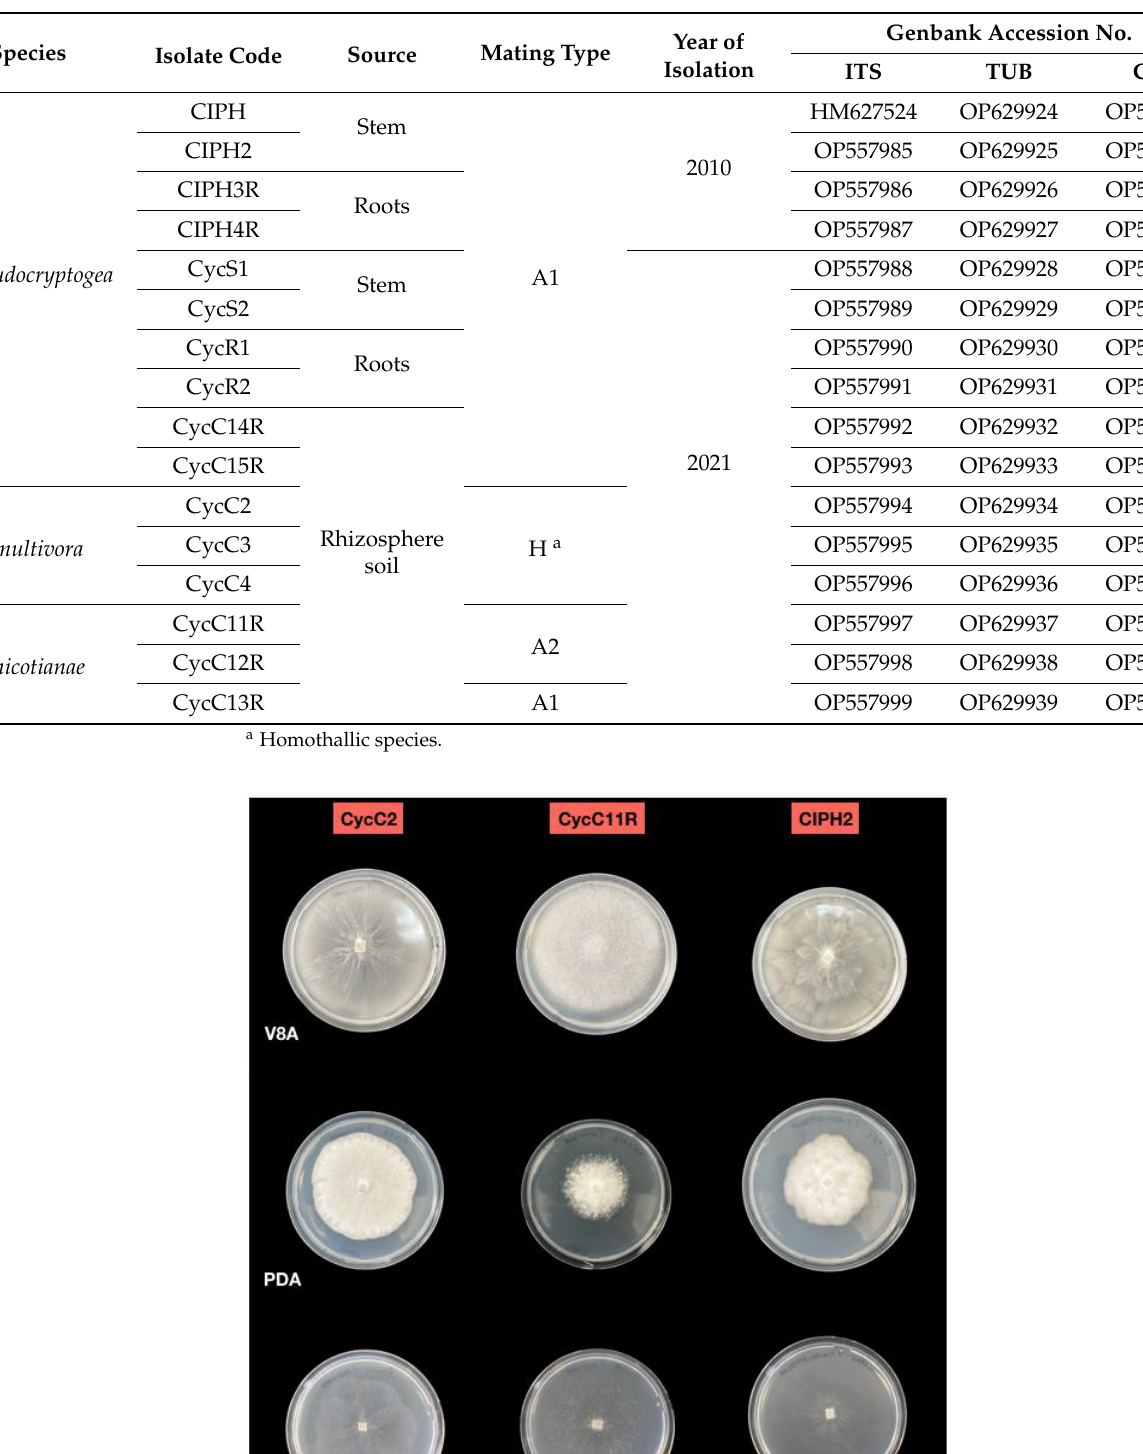
Table 1. Isolates of Phytophthora from the basal stem, roots and rhizosphere soil of sago palm characterized in this study.